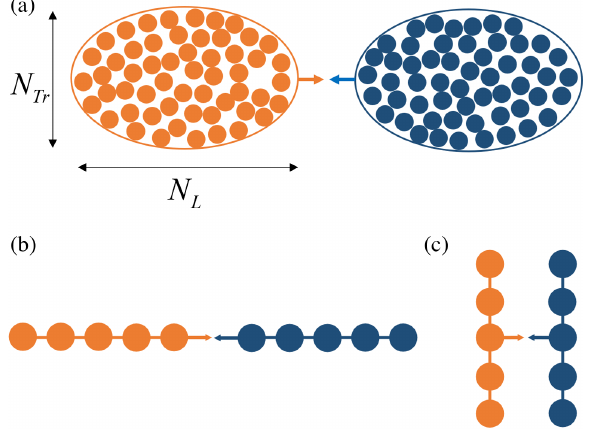
FIG. 4. Collision of the beams of different shapes: (a) general case (the beams have finite thickness and length), (b) elongated beams (each particle interacts with each: N 2 collisions), (c) short beams (each particle interacts with another: N collisions). For simplicity, the beams are depicted as having identical forms or sizes.